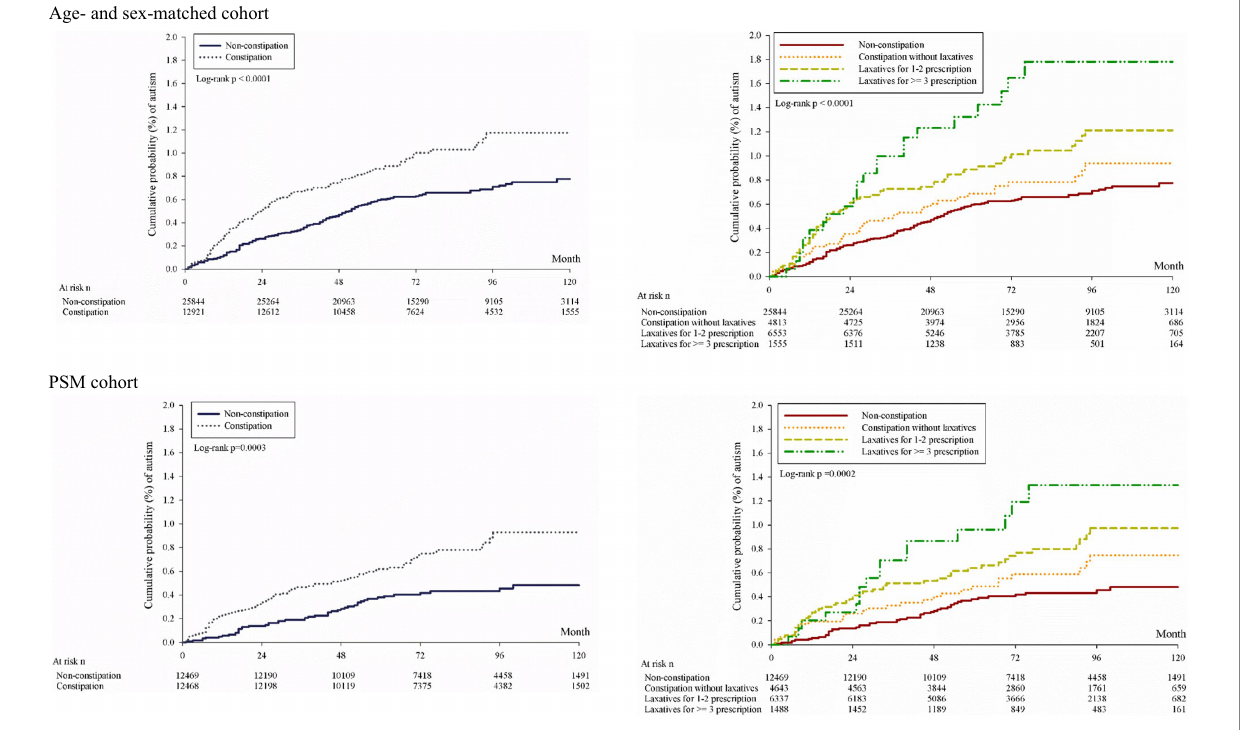
FIGURE 2 Kaplan–Meier curves of cumulative probability of development of autism. Age- and sex-matched cohort PSM